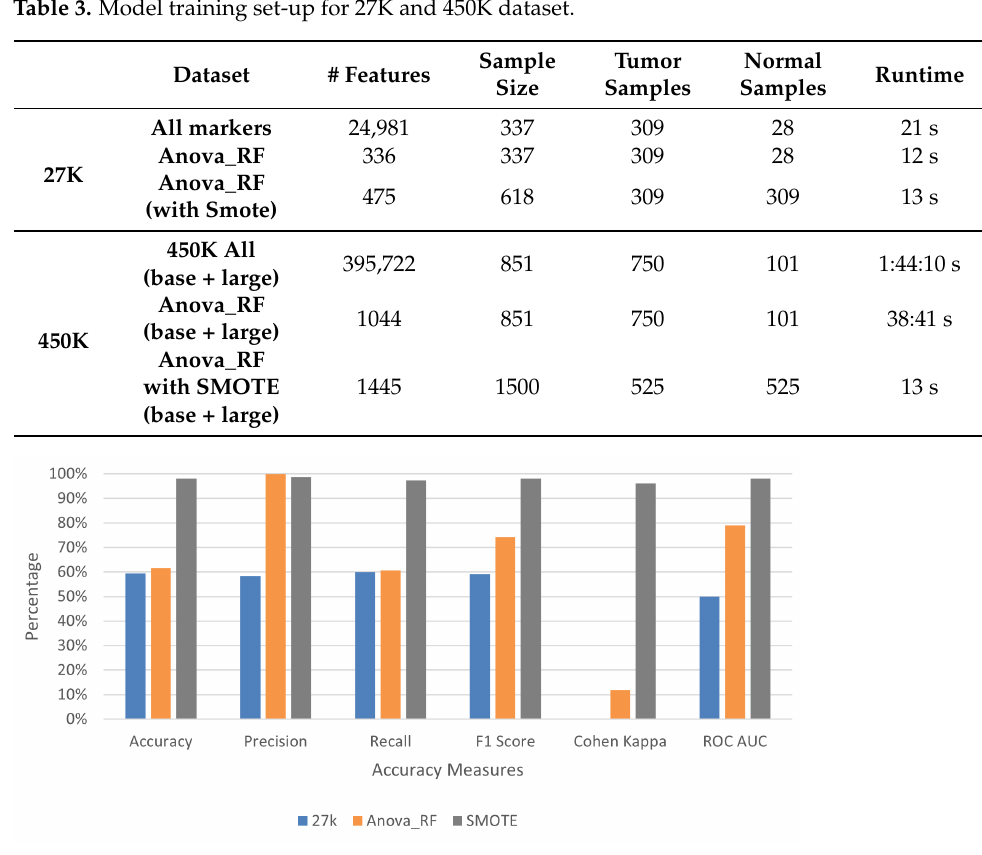
Figure 4. Accuracy metrics from deep learning models on 27K datasets before and after SMOTE application on training data using validation split of 30%. These graphs have been derived from average accuracy values of five trials shown in Table